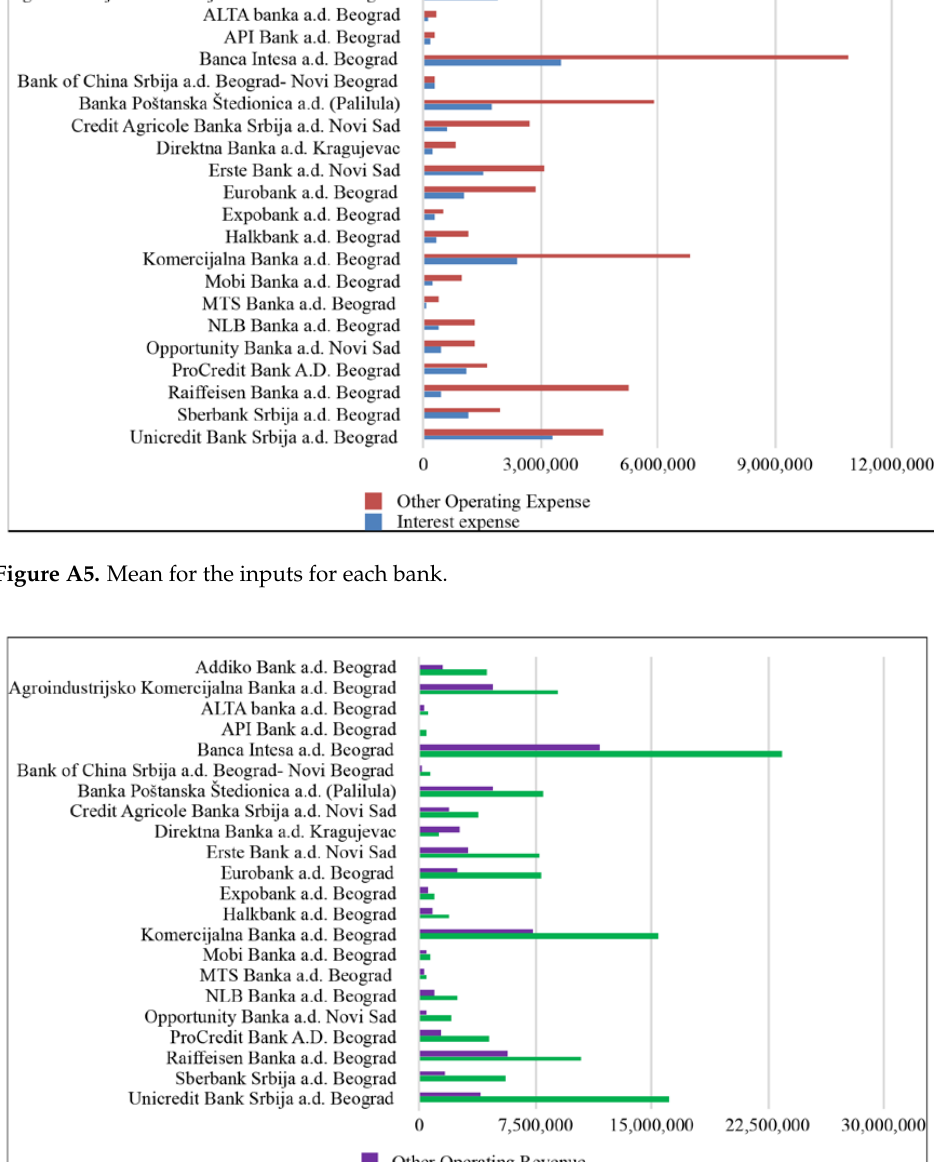
Croatia (in 000 HRK). Croatia (in 000